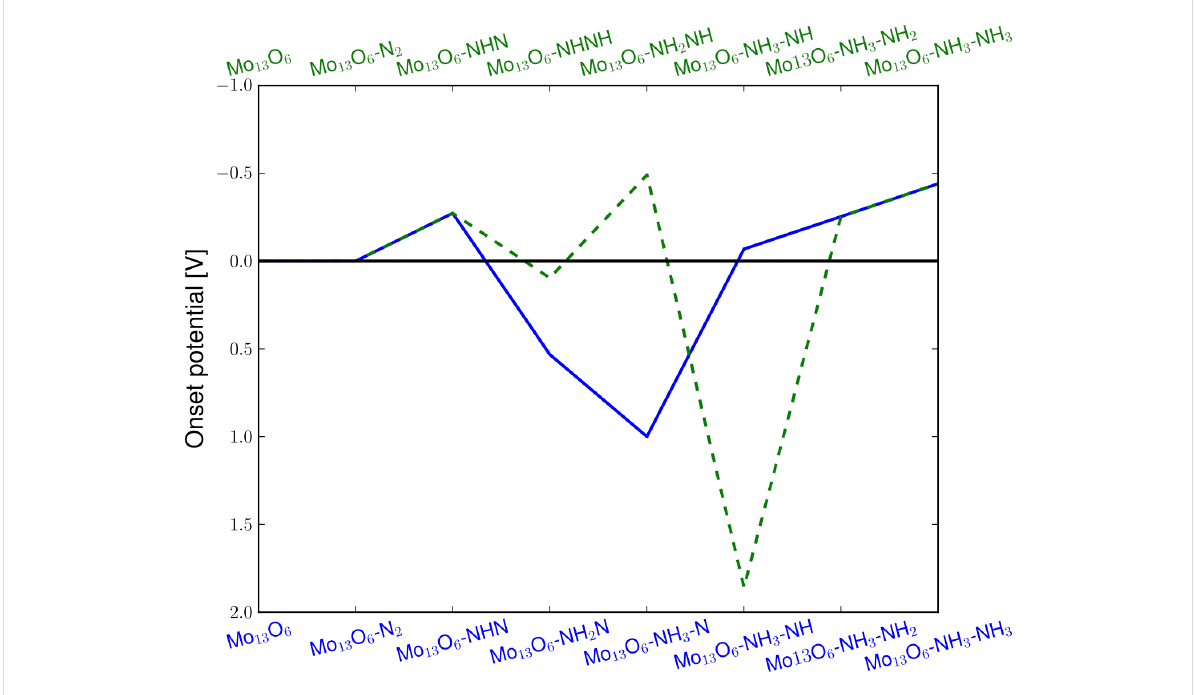
Figure 5: Diagram of the required applied potential to make each reaction step exergonic for electrochemical ammonia production on the Mo 13 O 6 through the associative mechanism. The limiting reaction is the last protonation to form the second ammonia on the surface requiring a potential of − 0.45 V to become